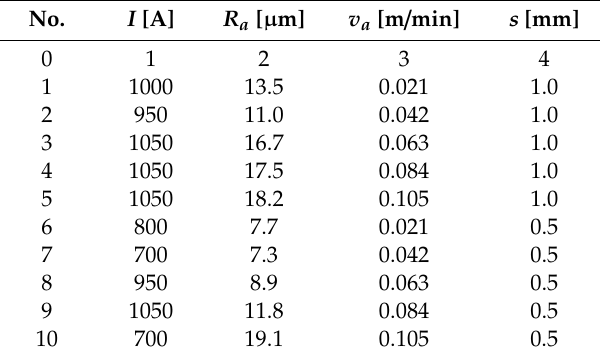
Table 6. Dependence of the thermal influenced area on the working current, on the feed rate of PO, and by the thickness of the metal band.